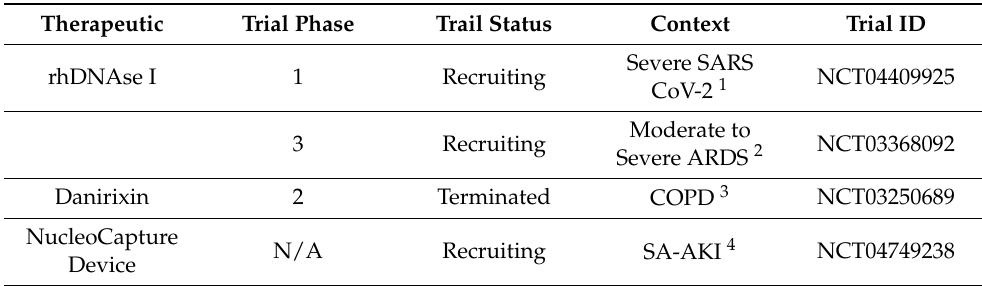
Table 2. Clinical Trials Targeting NETs in Various